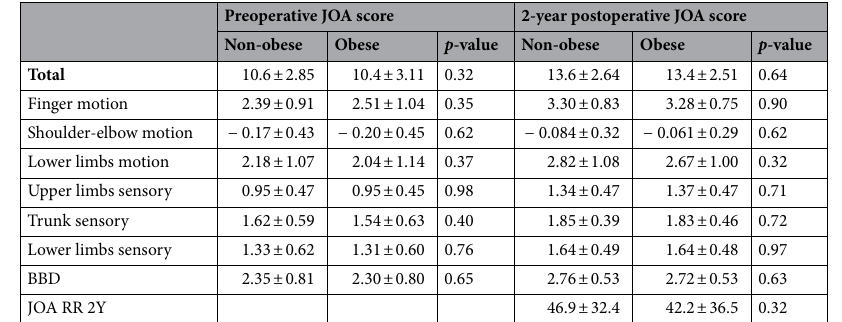
Table 7. Clinical condition at before and 2 years after surgery in obese and non-obese groups. JOA scores were represented by mean ± standard deviation. Non-obese: body mass index (BMI) < 30.0 kg/m 2 ; Obese: BMI ≥ 30.0 kg/m 2 ; BBD: bowel and bladder dysfunction; JOA RR 2Y: Japanese Orthopedic Association recovery rate after 2 years surgery; MCID: minimal clinically important difference.